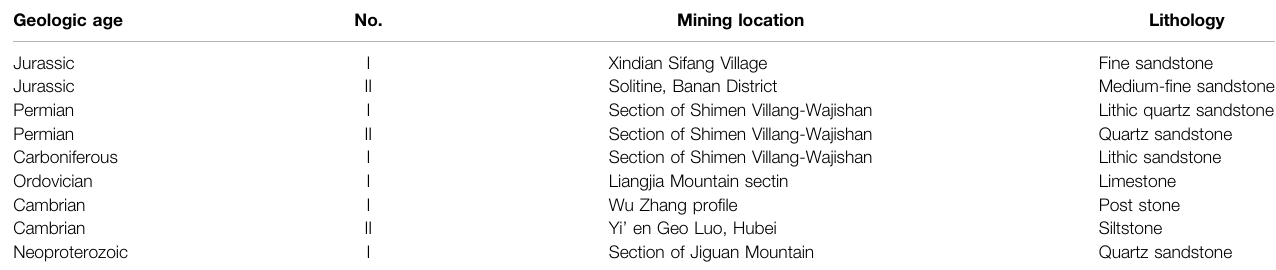
TABLE 1 | Information for the nine sedimentary rocks.